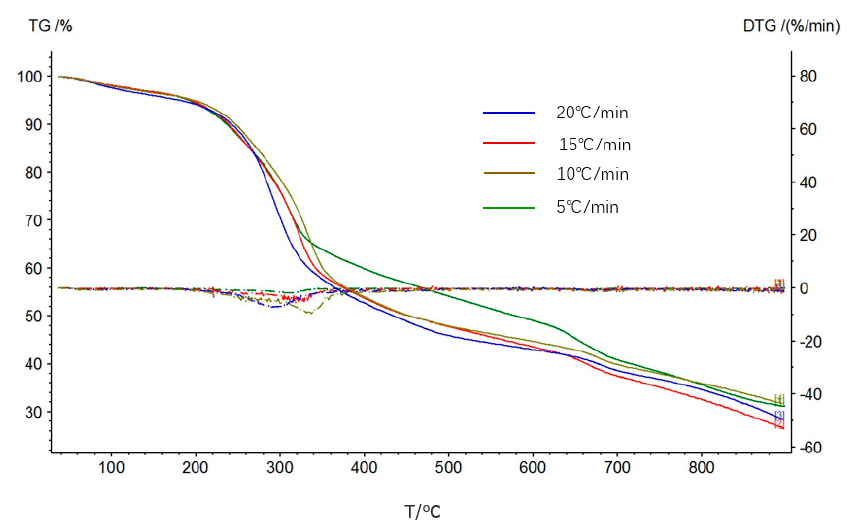
Figure 3. The TG and DTG curves of the chicken manure pyrolysis for different heating rates in the presence of nitrogen atmosphere.